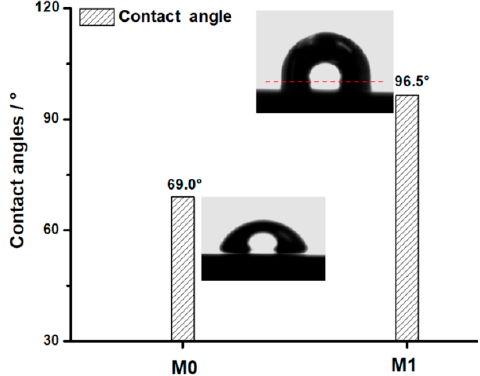
Figure 4. Evolution of contact angle measured by deionized water for bare (M0) and N + + Ti + ion ‐ implanted (M1) M50 bearing steel specimens.